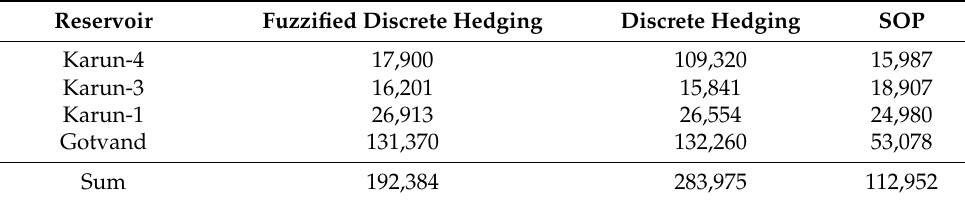
Table 8. Total spillage